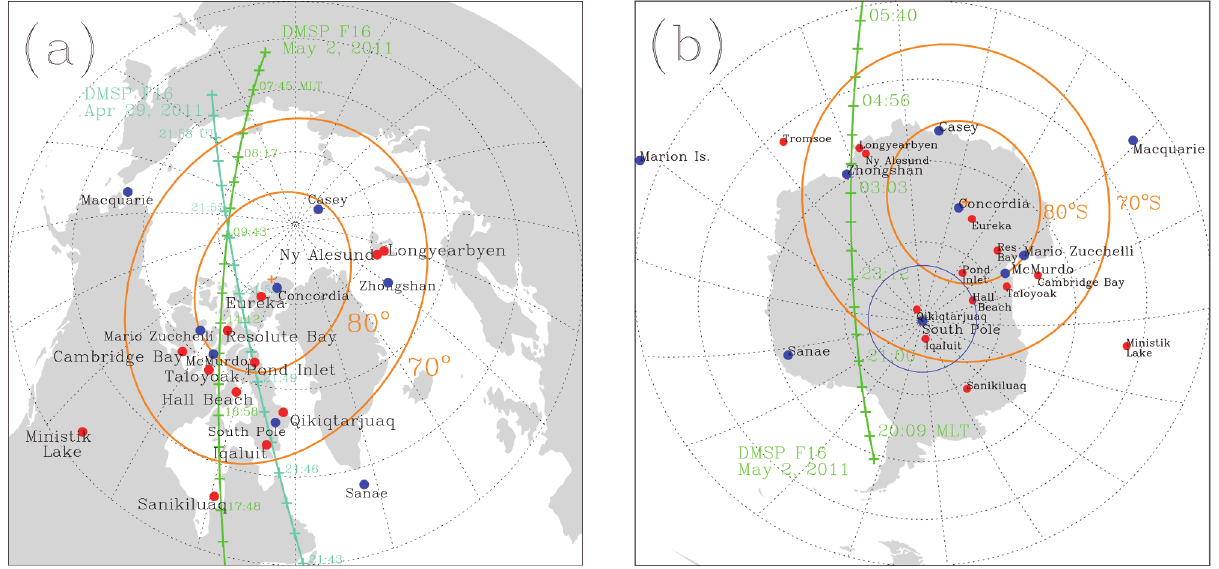
Figure 1. (a) The CHAIN and European GISTMs (red dots) and conjugate locations of southern hemisphere GISTMs (blue dots). Corrected geomagnetic (CGM) latitudes 70º N and 80º N and two DMSP F16 satellite tracks are superposed. The times shown on the DMSP tracks are in UT and MLT for April 29 (cyan) and May 2 (green), respectively. (b) The southern hemisphere GISTMs (blue dots) and conjugate loca- tions of CHAIN and European GISTMs (red dots). The field of view of an all-sky imager at SP is shown. Corrected geomagnetic (CGM) lat- itudes 70º S and 80º S (orange) and a DMSP F16 satellite track are